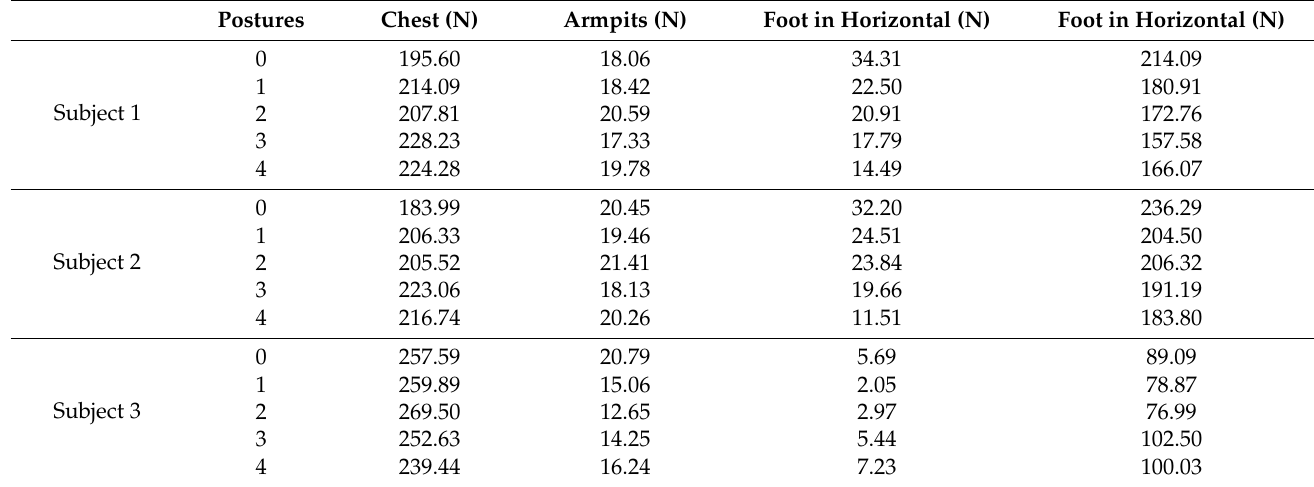
Table 5. The comfort force